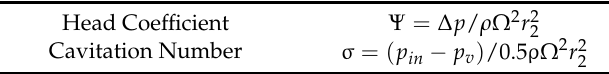
Table 5. Cavitating performance